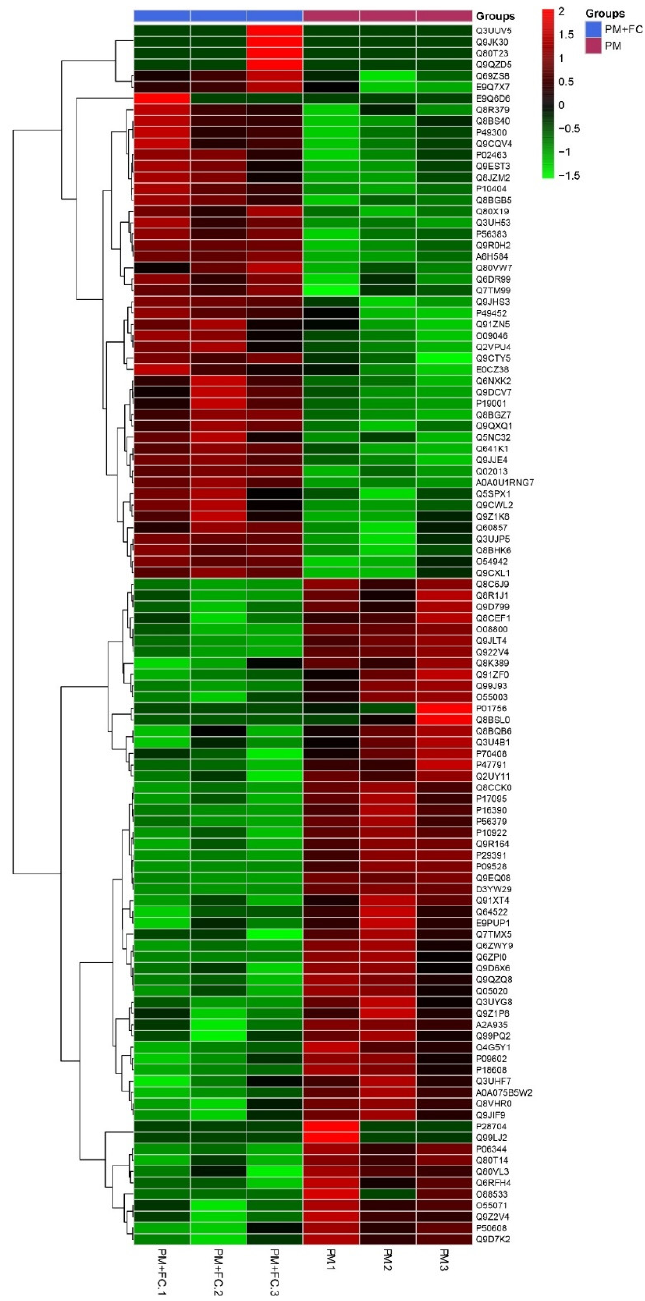
Figure 6. Hierarchical cluster analysis (HCA) of different protein expressions in mouse lung tissues between group PM + FC and group PM through the pheatmap package (https://CRAN.R-project.org/package=pheatmap assessed on 6 June 2021).